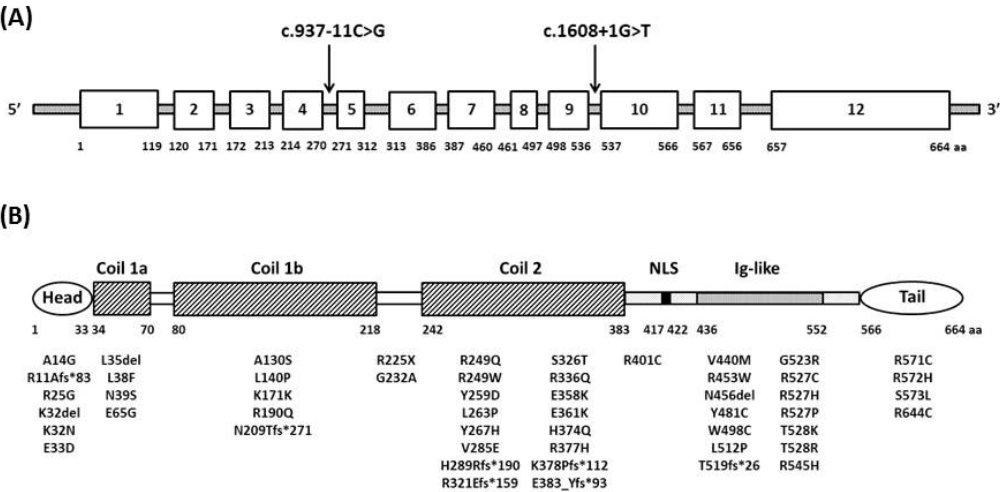
Figure 2. This is a schematic representation of the LMNA gene ( A ) and the lamin A/C protein ( B ). Mutations associated with laminopathy and identified in Italian patients are indicated with the corresponding nucleotide ( A ) or amino acid ( B ) changes. The globular head and tail domains are shown as an oval. The coil 1 (segments 1A and 1B), and coil 2 (segments 2A and 2B), constituting the α -helical rod domain, are shown as rectangles. Double lines represent linkers L1, L2 and L12. NLS = nuclear location signal; Ig = immunoglobulin. Modified from Neurology 2014, 83, 1634–1644 [5].